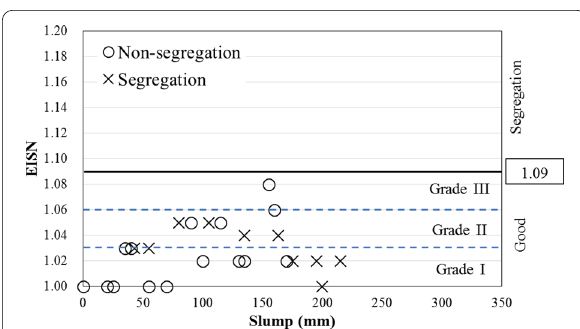
Fig. 15 Categorizing grades of concrete mixtures depending on EISN for normal concrete mixtures. The evaluation of segregation or non‑segregation is the result of Maruya et al.’s method, and this method is recognized as limited under these conditions.